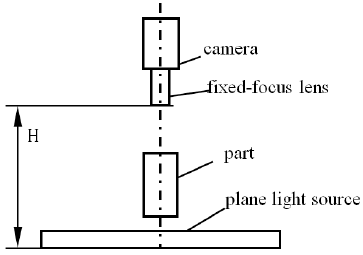
Figure 1. Schematic diagram of the roundness error measurement device.